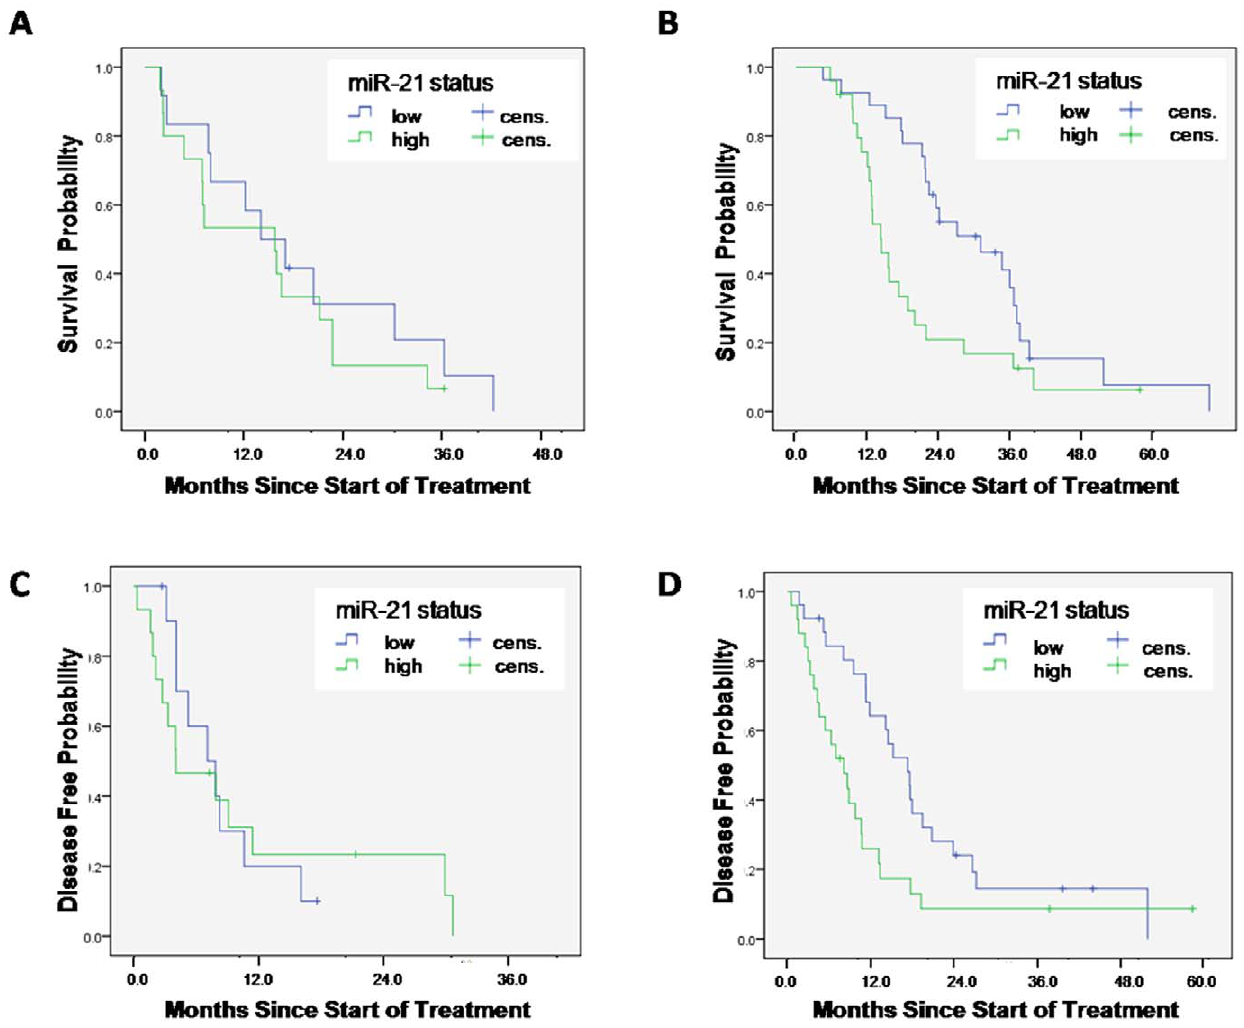
Figure 1. Survival analysis of adjuvant treated and not adjuvant treated patients. Overall survival according to miR-21 status in (A) not adjuvant treated patients and (B) adjuvant treated patients. Disease-free survival according to miR-21 status in (C) not adjuvant treated patients and (D) adjuvant treated patients. Cens.: censored .